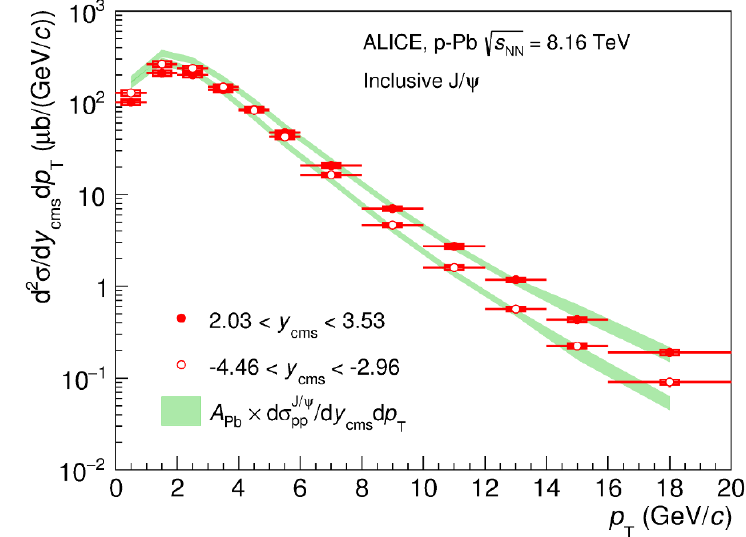
Figure 3 . The p T -di(cid:11)erential inclusive J/ production cross section in p{Pb and Pb{p collisions p at s NN = 8 : 16 TeV. The vertical error bars (not visible because smaller than the symbols) represent the statistical uncertainties, the boxes around the points the systematic uncertainties. The horizontal bars correspond to the bin size. The values of the reference pp cross sections, obtained through the interpolation/extrapolation procedure described in section 3, scaled by A Pb , are shown as bands.